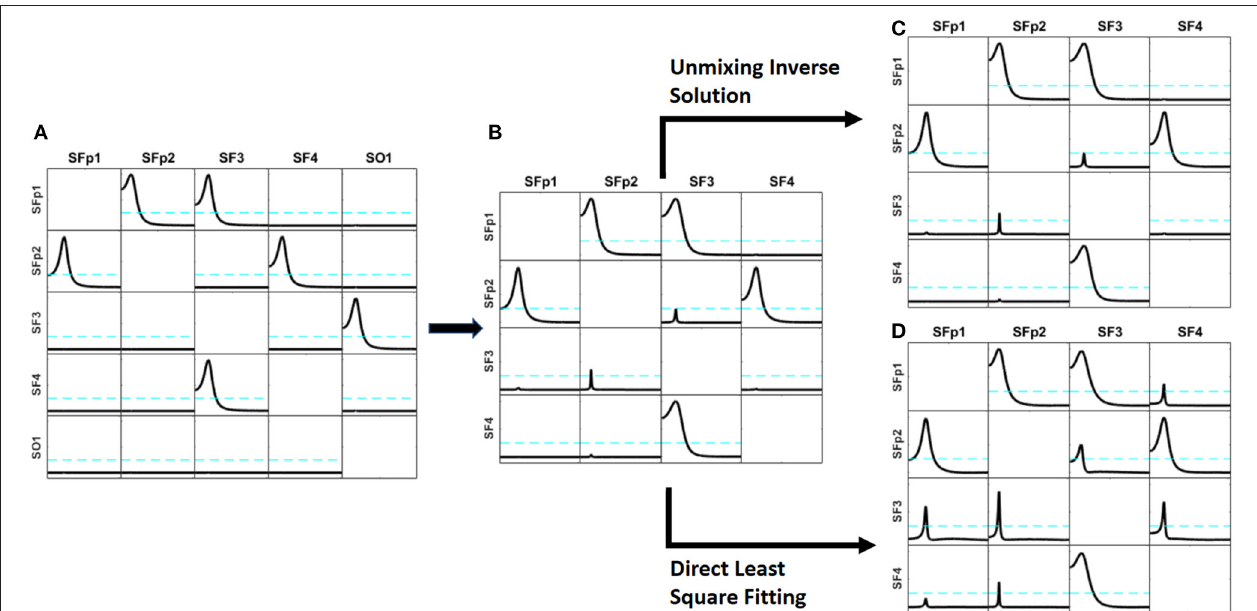
FIGURE 3 | Comparison of the results obtained by the unmixing procedure after the distributed inverse solution vs. the direct solution of the problem by Least Square solution. Panel (A) shows the exact simulation used. Panel (B) shows the reconstruction of the patterns of influence by iCoh when one of the simulated signals (sO1) is ignored; observe that very small artifacts appear. Panel (C) shows the iCoh results using the signals reconstructed at the sources after solving the inverse problem and applying the unmixing procedure ignoring sO1; note that it almost the same as Panel (B) , no better result can be expected. Panel (D) shows the iCoh reconstruction of influences using the signals obtained by direct estimation of the model by Least Square ignoring sO1; observe that many spurious patterns appear where the influence should have been zero, although the real patterns between the included regions are well